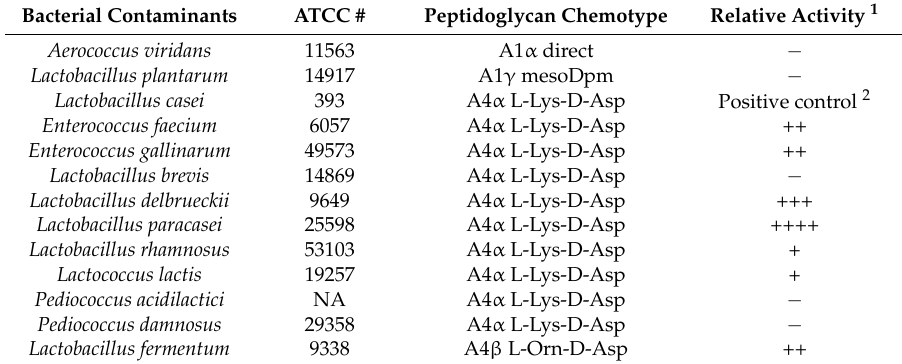
Table 2. Lytic activity of LysA2 produced intracellularly by P. pastoris against 13 lactic acid bacteria representative of common biofuel